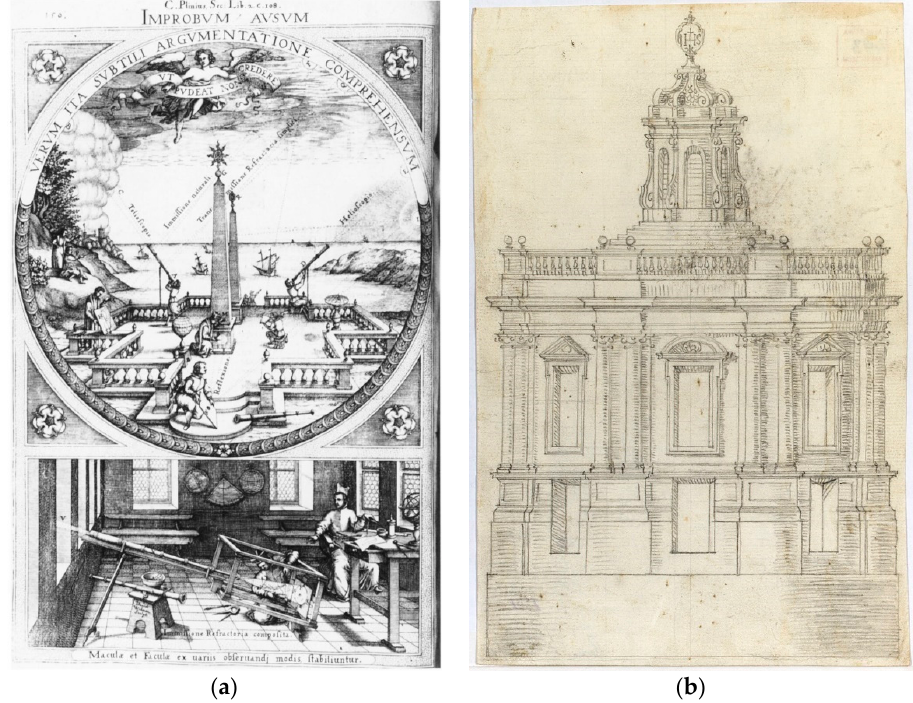
Figure 5. ( a ) Daniel Widman, 1626–1630, Observation of sunspots, in Christian Scheiner Rosa